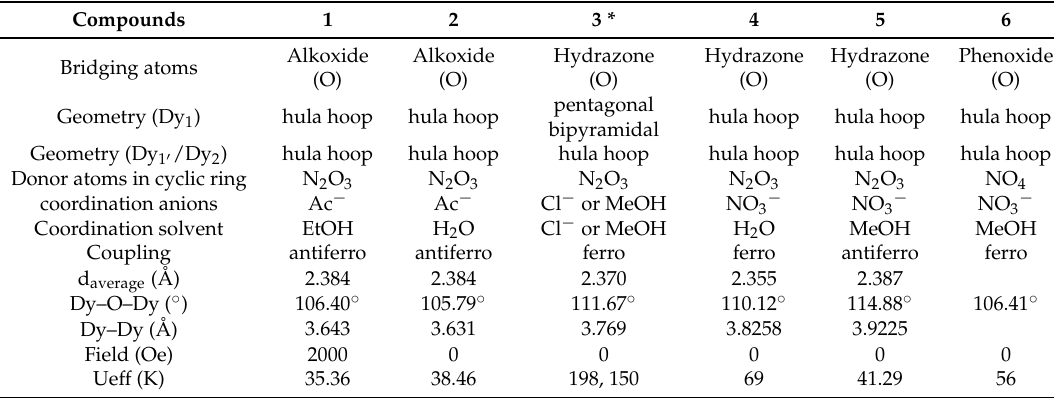
Table 1. Selected parameters of structure of 1 , 2 and reported Dy 2 compounds based on related ligands ( 3 – 6 ).